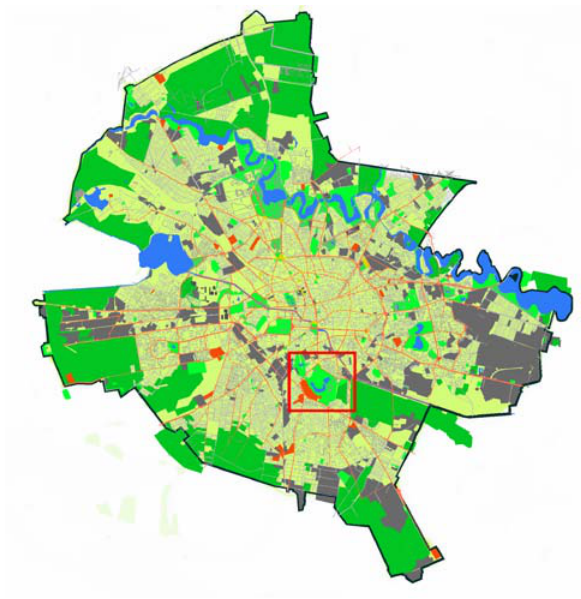
Figure 1. Study area delimited on Bucharest map (red rectangle) The road traffic system’s infrastructure is based on a network of avenues which form a radial layout, starting in the downtown and expanding towards the city suburbs where they connect with roads to other major cities in the area. There is also a layout of important avenues which cross the city from one end to another (north to south, east to west, north-west to south-east) and two bypass roads around it (an inner and an outer road belt) which greatly improve the traffic flow in and around the